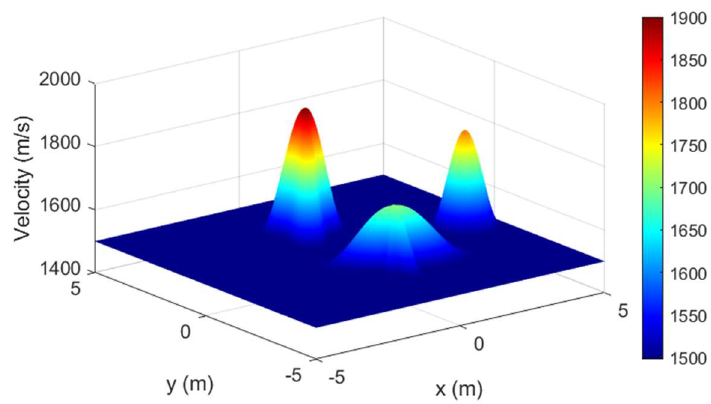
Figure 11. Velocity distribution in the heterogeneous domain for Example 3.